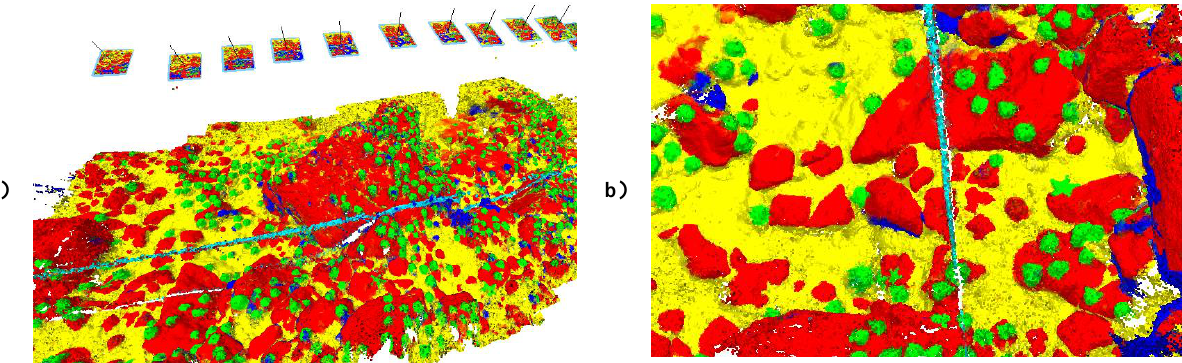
Figure 4. Multi-view semantic segmentation propagation from 2D to 3D. A 3D view of the segmented point cloud along with the camera poses in space (a) and a top view (b) of the point cloud as seen in the test image of Figure